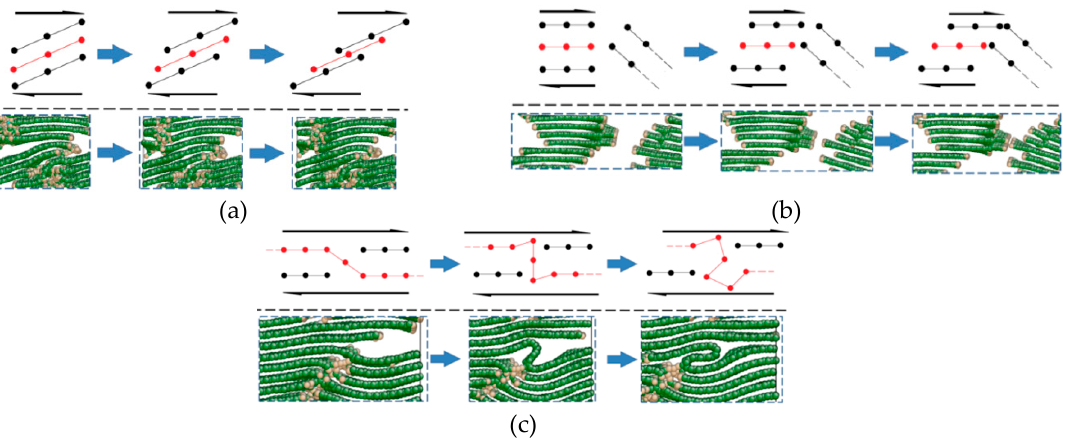
Figure 13. Typical failure modes of the C f /PyC interphase under a tangential shear load when